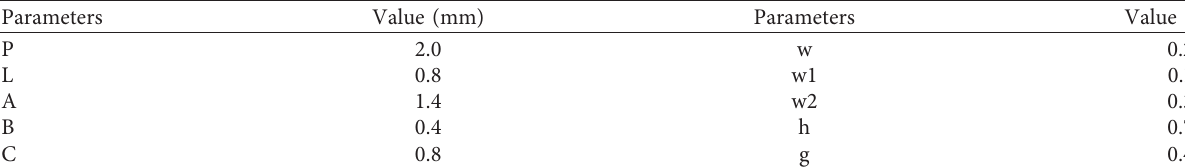
Figure 4: Structural diagram of the proposed absorber: (a) front view and (b) side view. Table 1: Geometric parameters of the proposed structure.